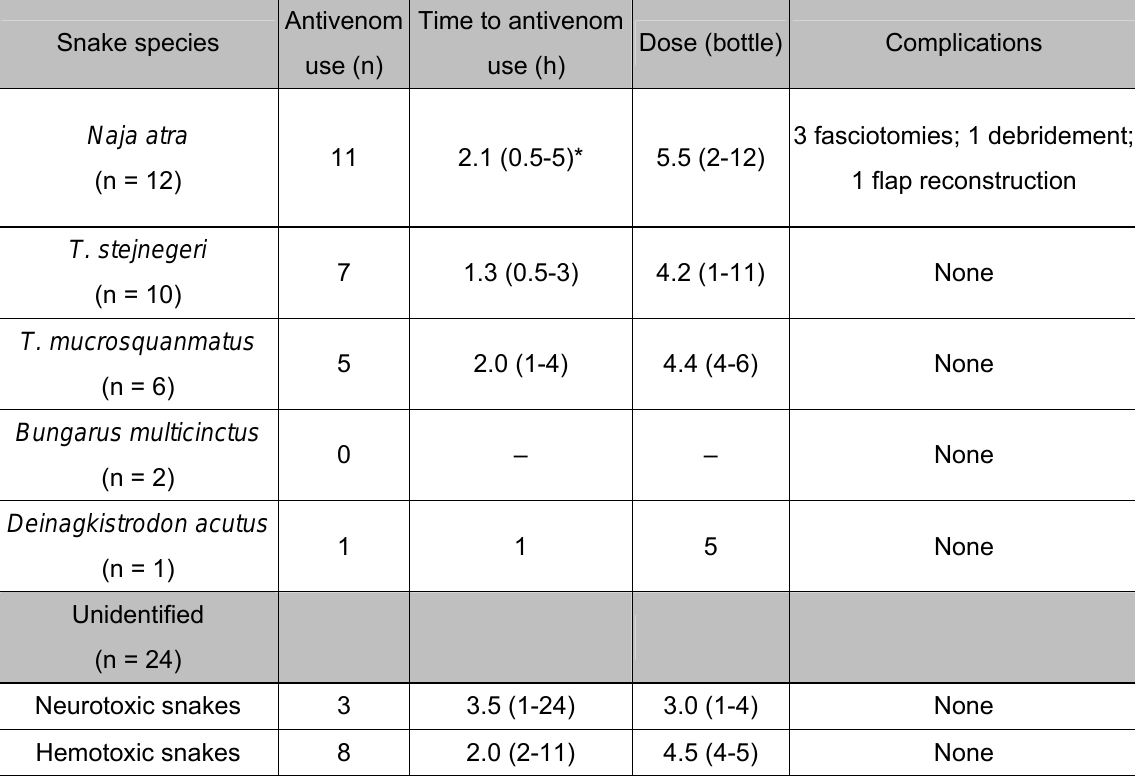
Table 3. Antivenom treatment and complications of children bitten by snakes (n =